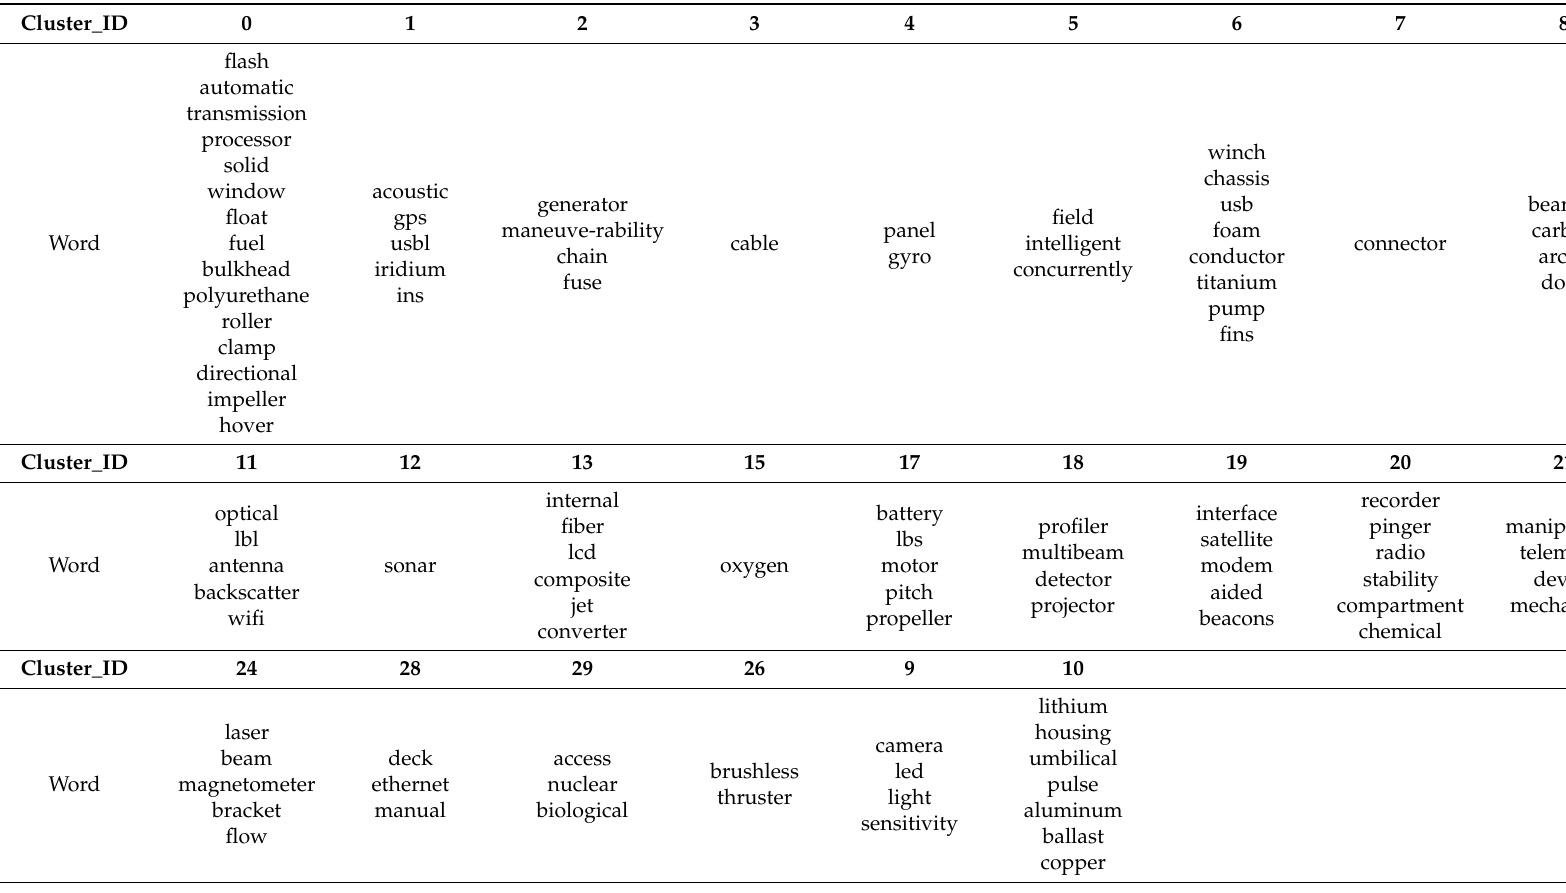
Table A1. K-means clustering results of technology